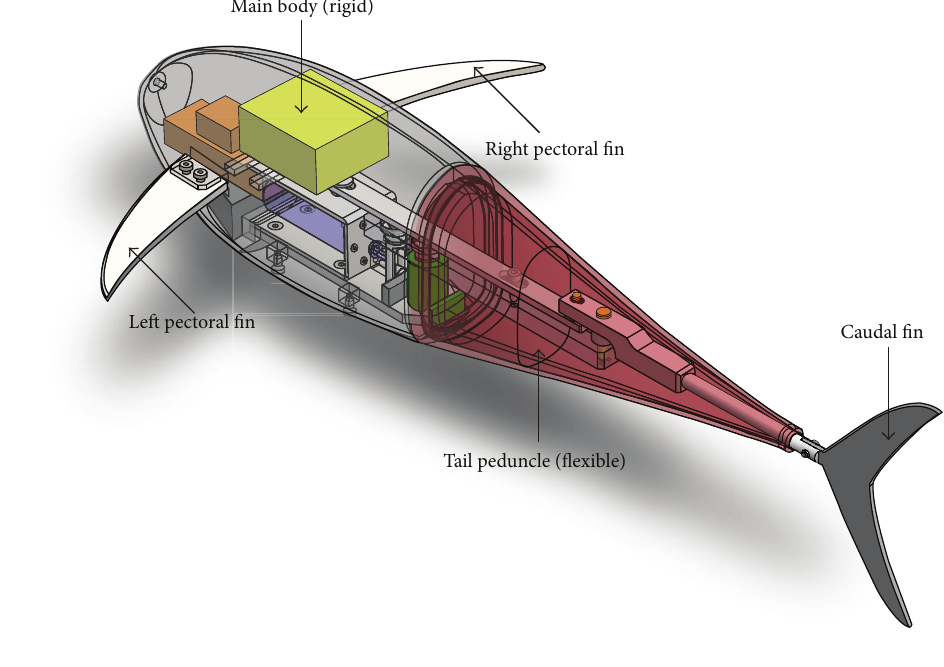
Figure 2: The CAD design of UC-Ika 1.